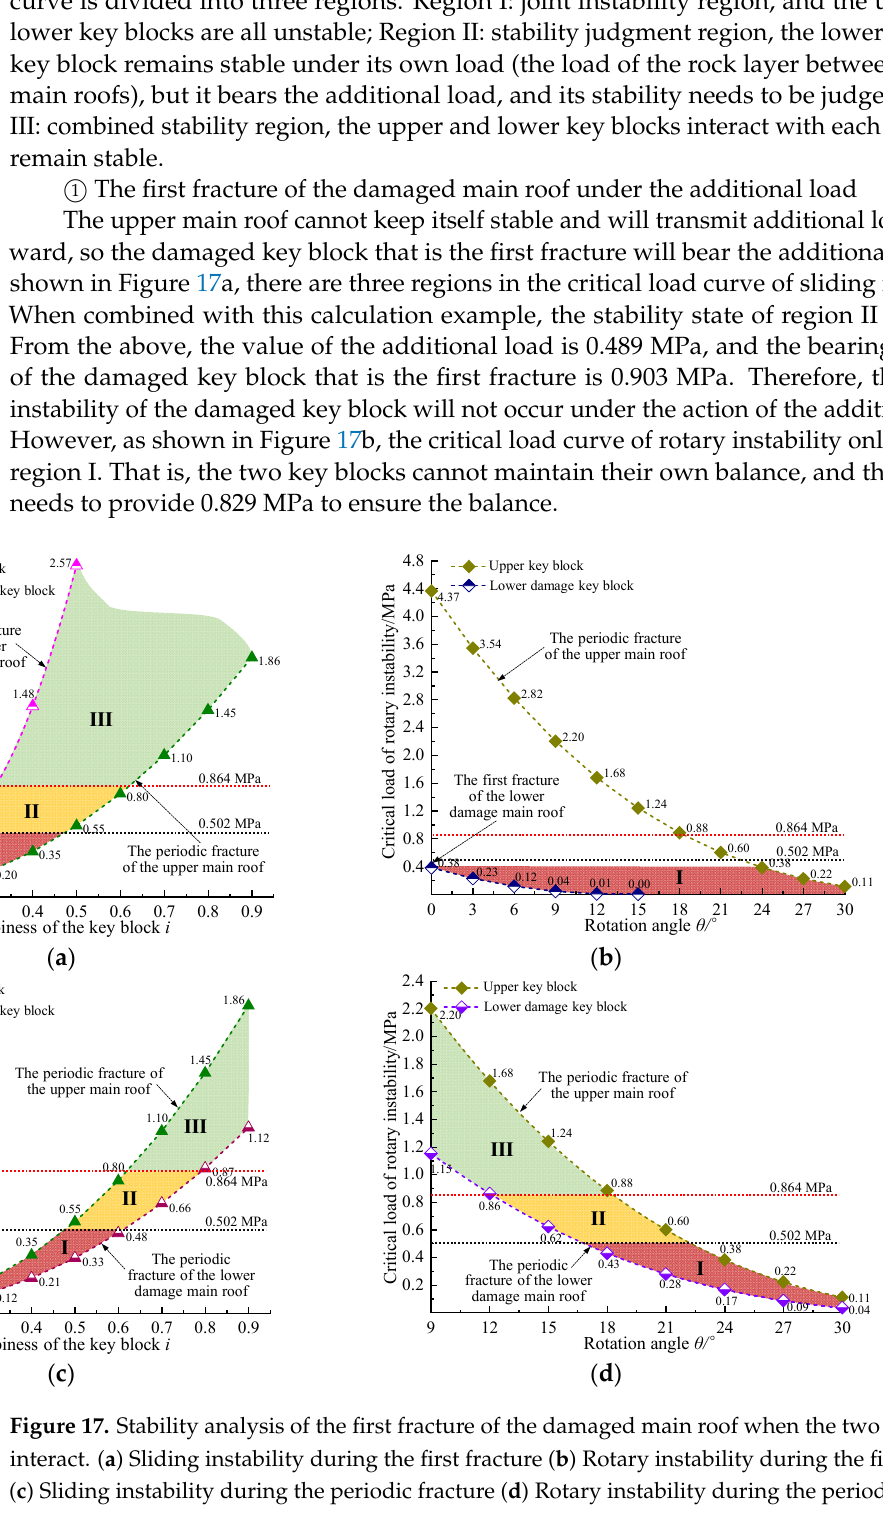
(3) Combined stability analysis of the upper and lower main roofs with different properties According to the stability of the overlying and underlying main roofs, the critical load curve is divided into three regions. Region I: joint instability region, and the upper and lower key blocks are all unstable; Region II: stability judgment region, the lower damaged